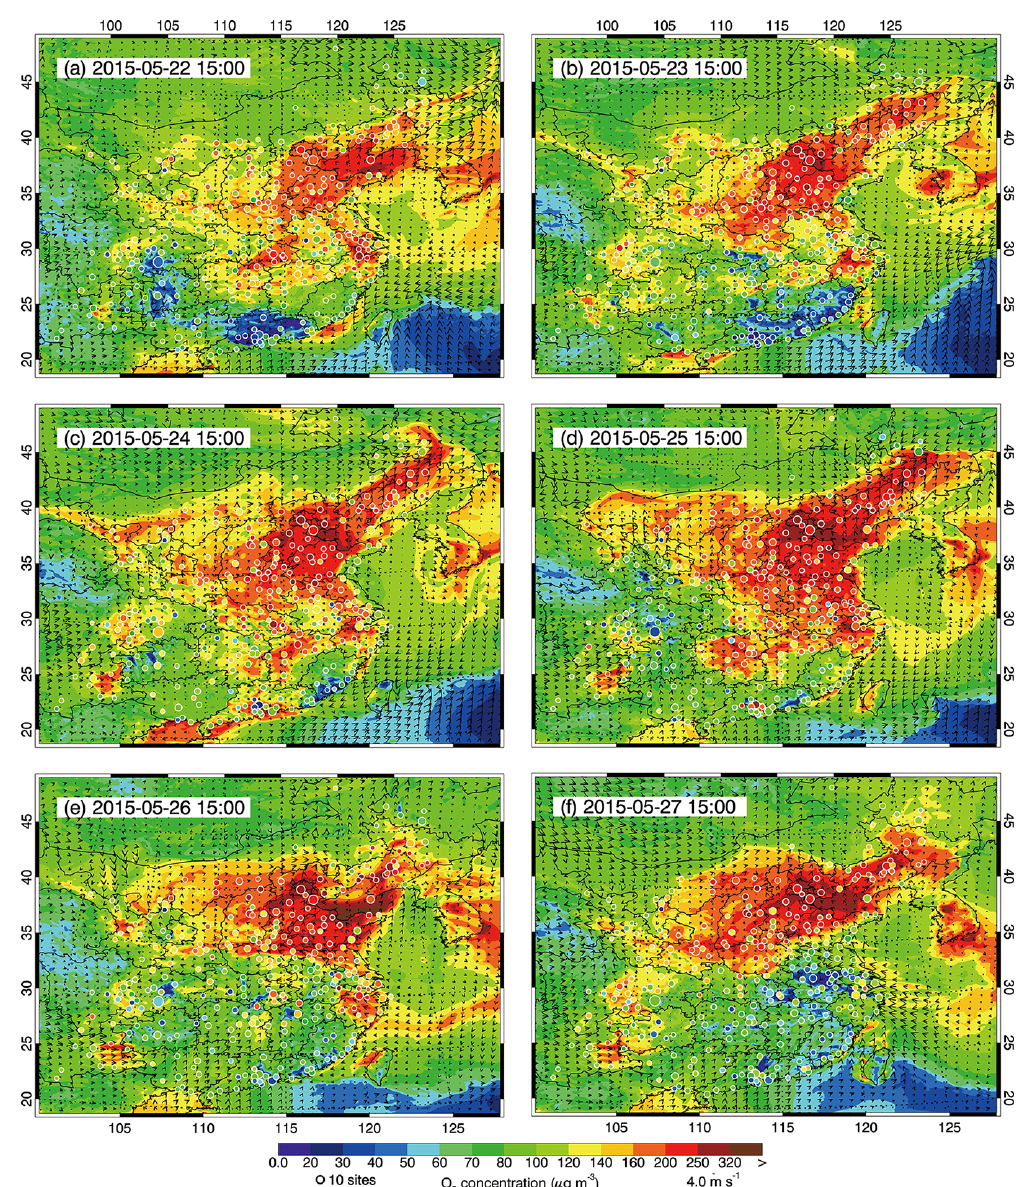
Figure 6. Pattern comparison of simulated versus observed near-surface O 3 at 15:00BJT from 22 to 27 May 2015. Colored circles: O 3 observations; color contour: O 3 simulations; black arrows: simulated surface